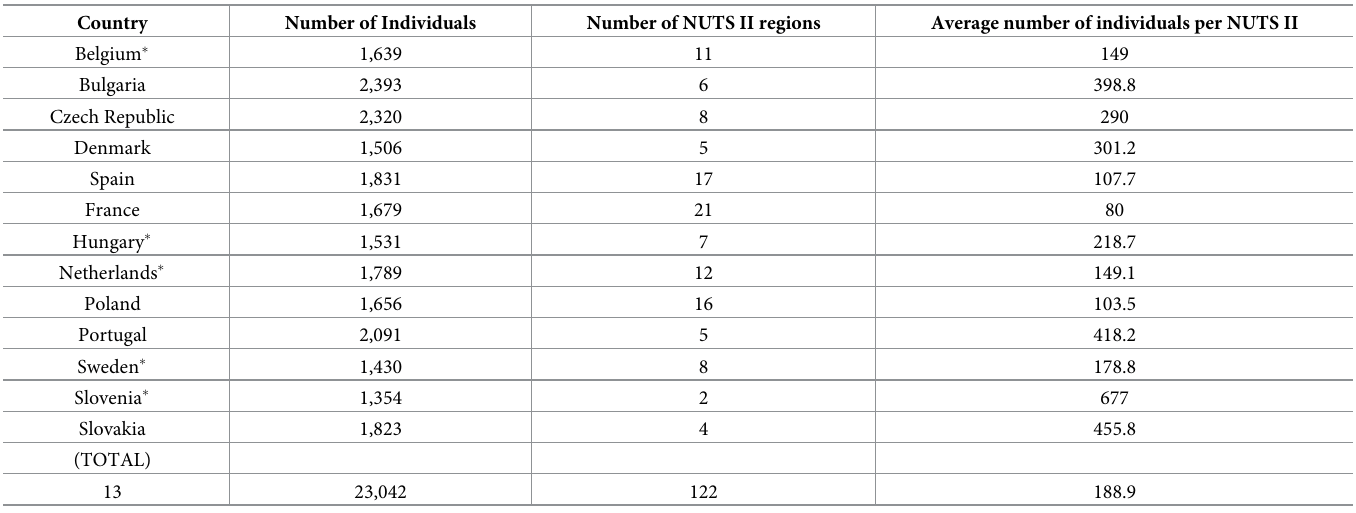
Table 1. Sample size, countries and NUTS II